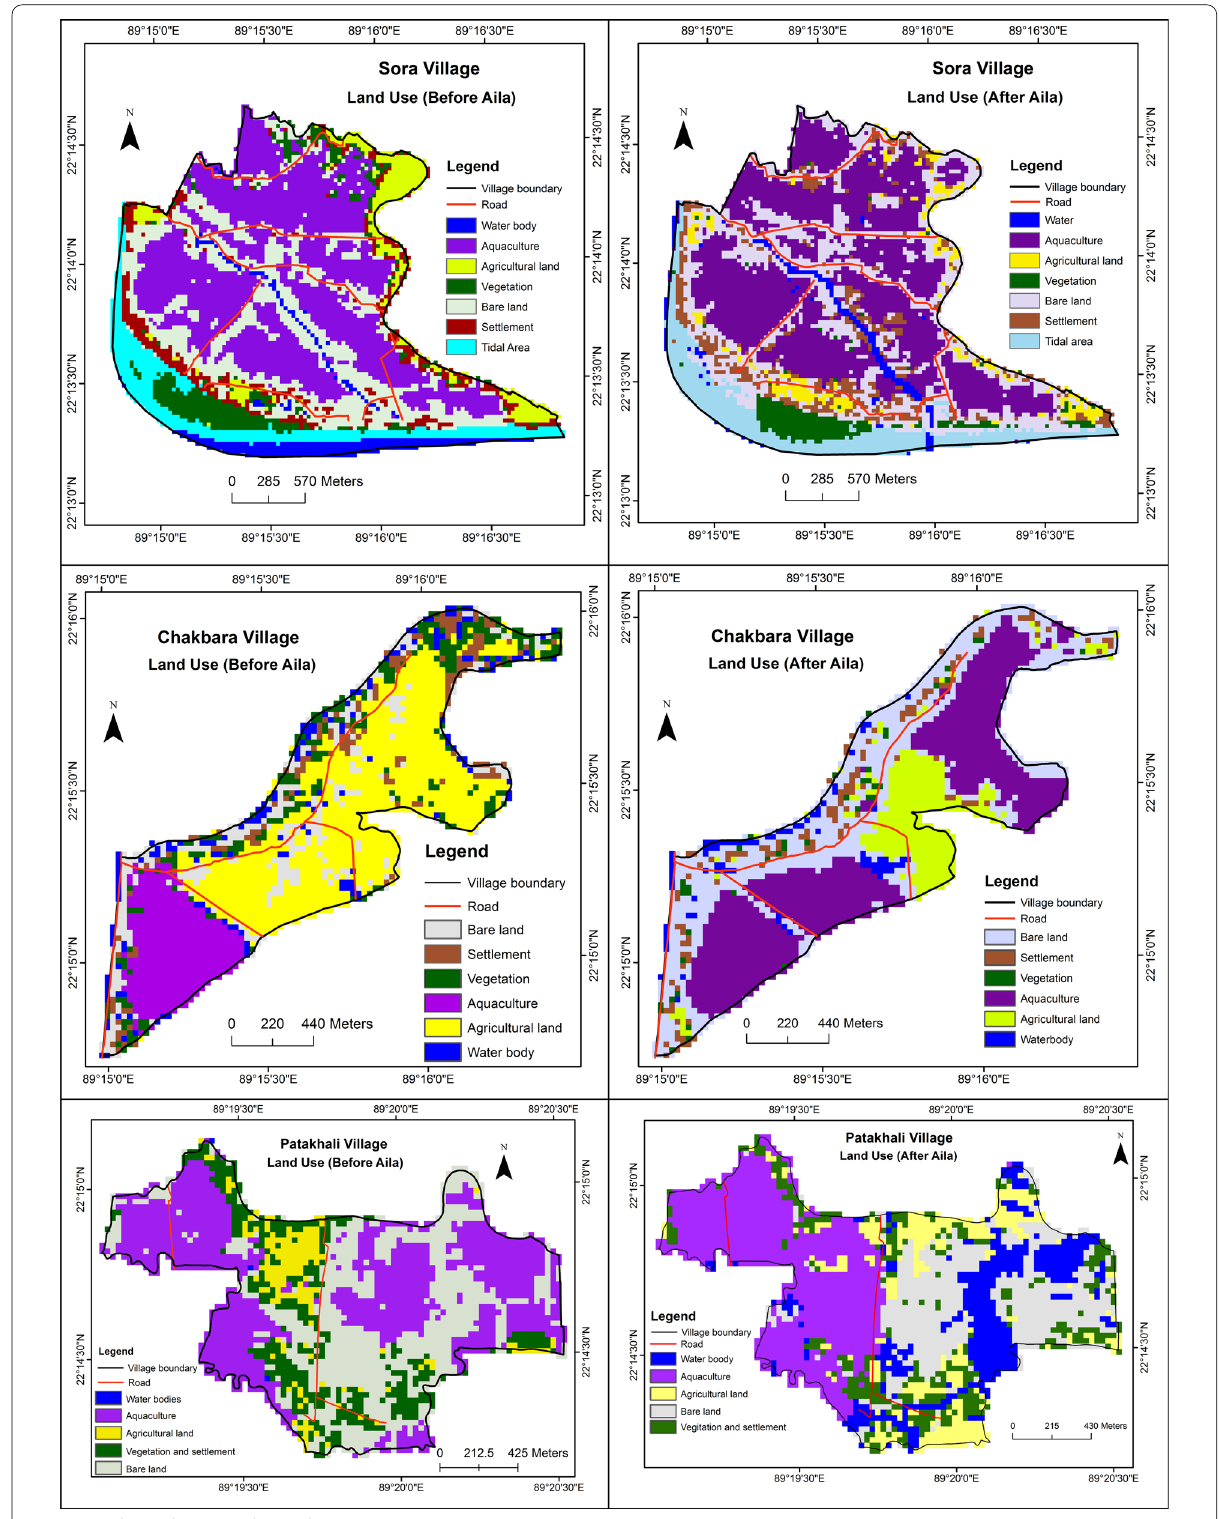
Fig. 6 Land Use change in the study